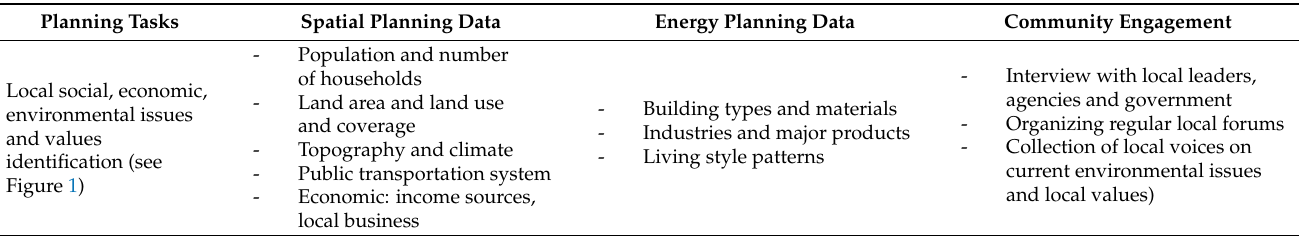
Table 1. LCC’s data use inventory for each phase of energy planning, spatial planning and commu- nity